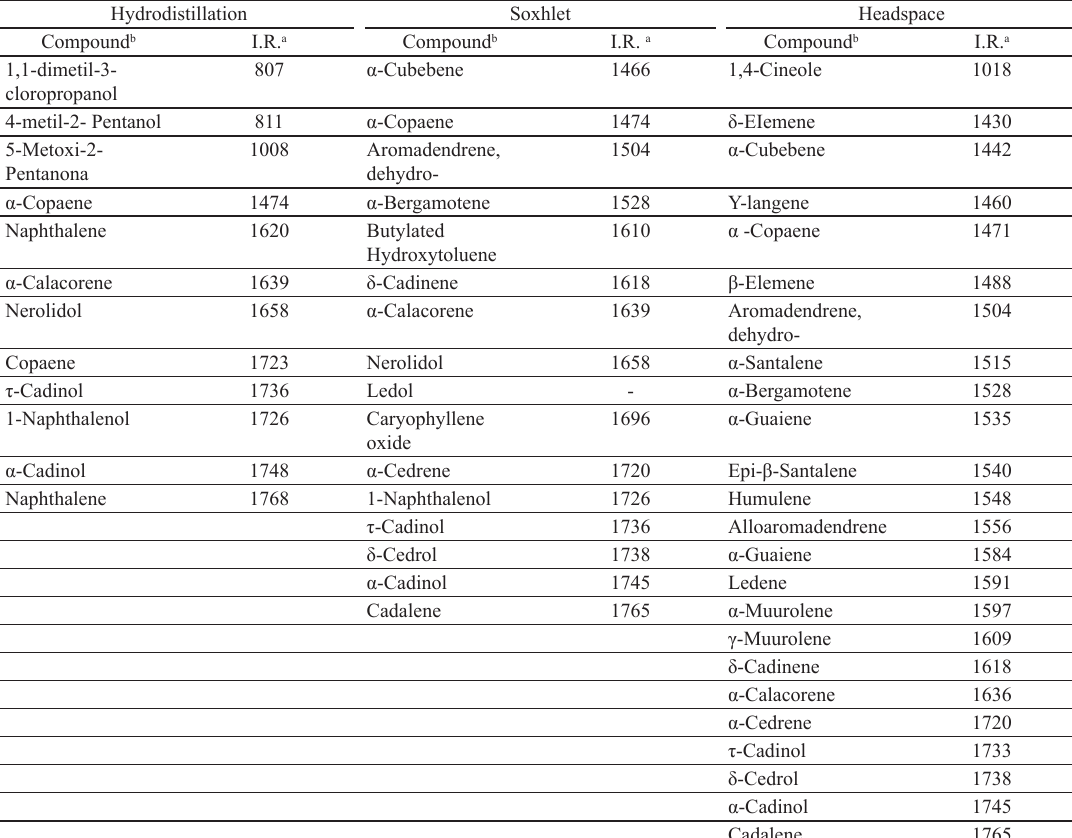
Table 11. Compounds detected in Cedrella fissilis essential oils extracted by hydrodistillation, soxhlet and headspace. Hydrodistillation Soxhlet